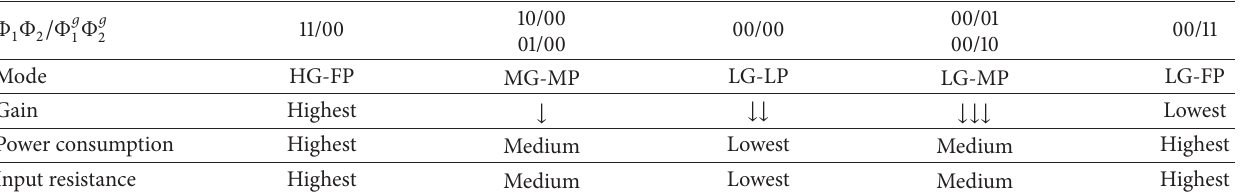
Table 1: Summary of operation modes features.